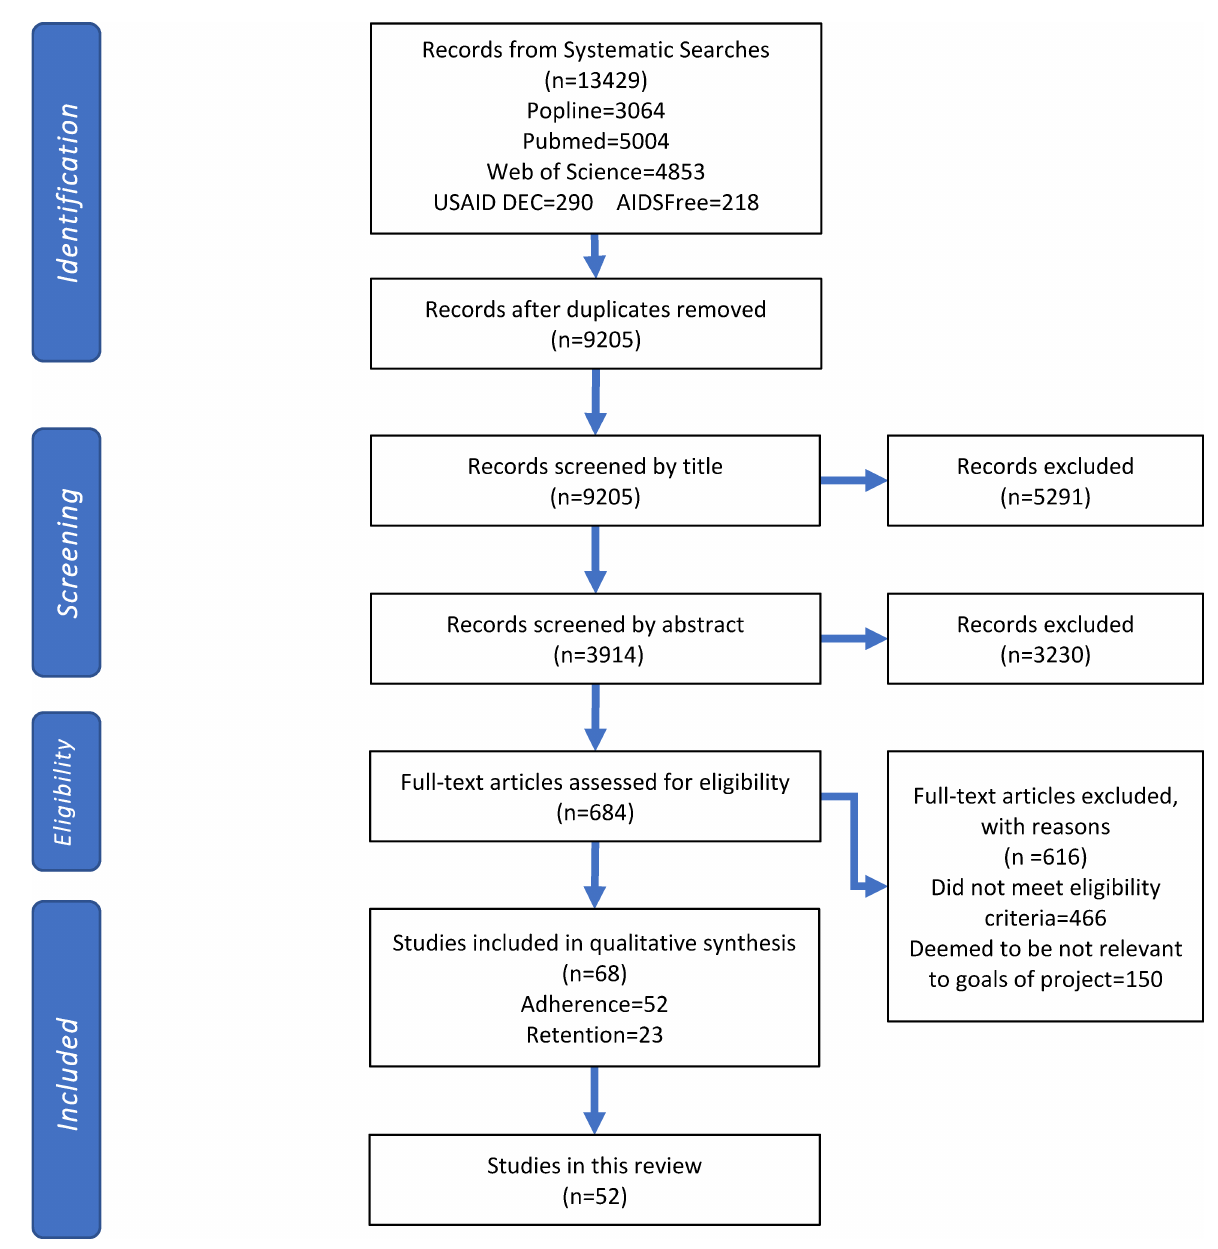
Fig 1. Selection process for inclusion of